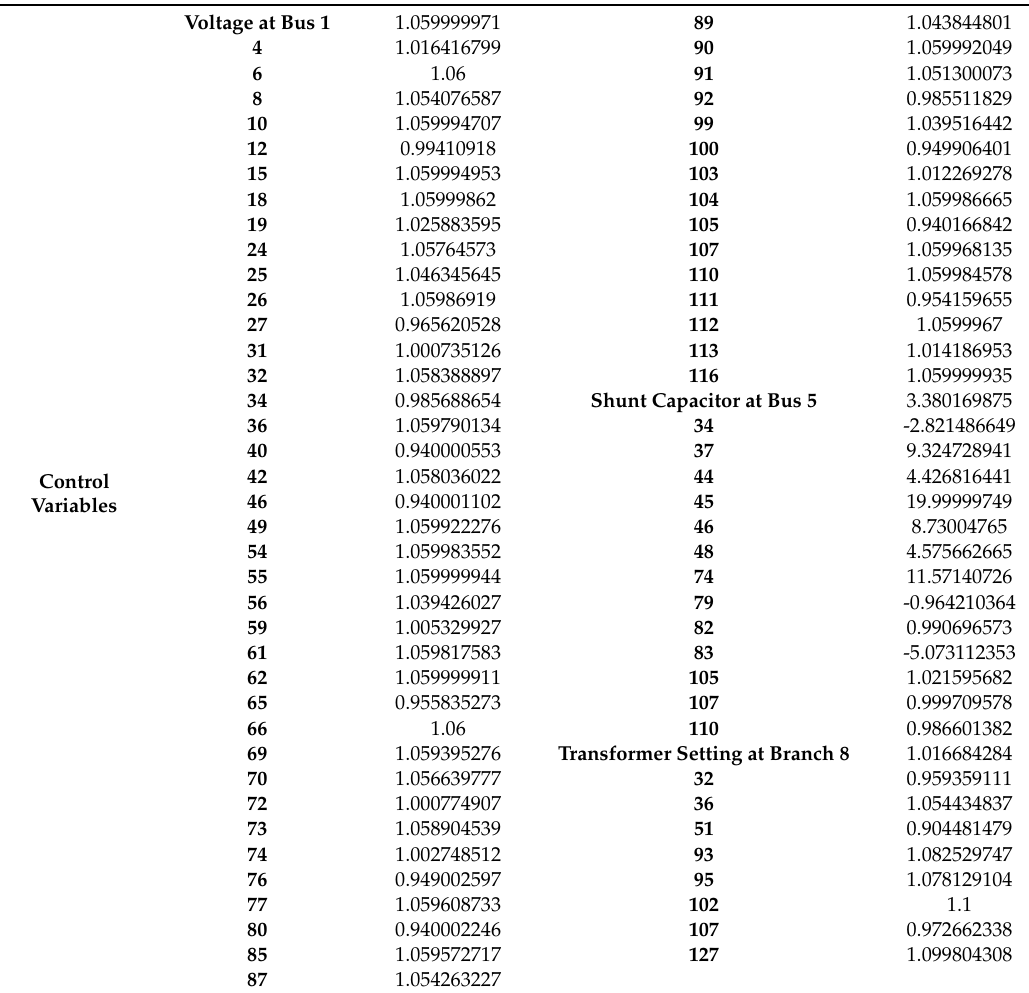
Table 10. 118-bus system decision variables for the first case.